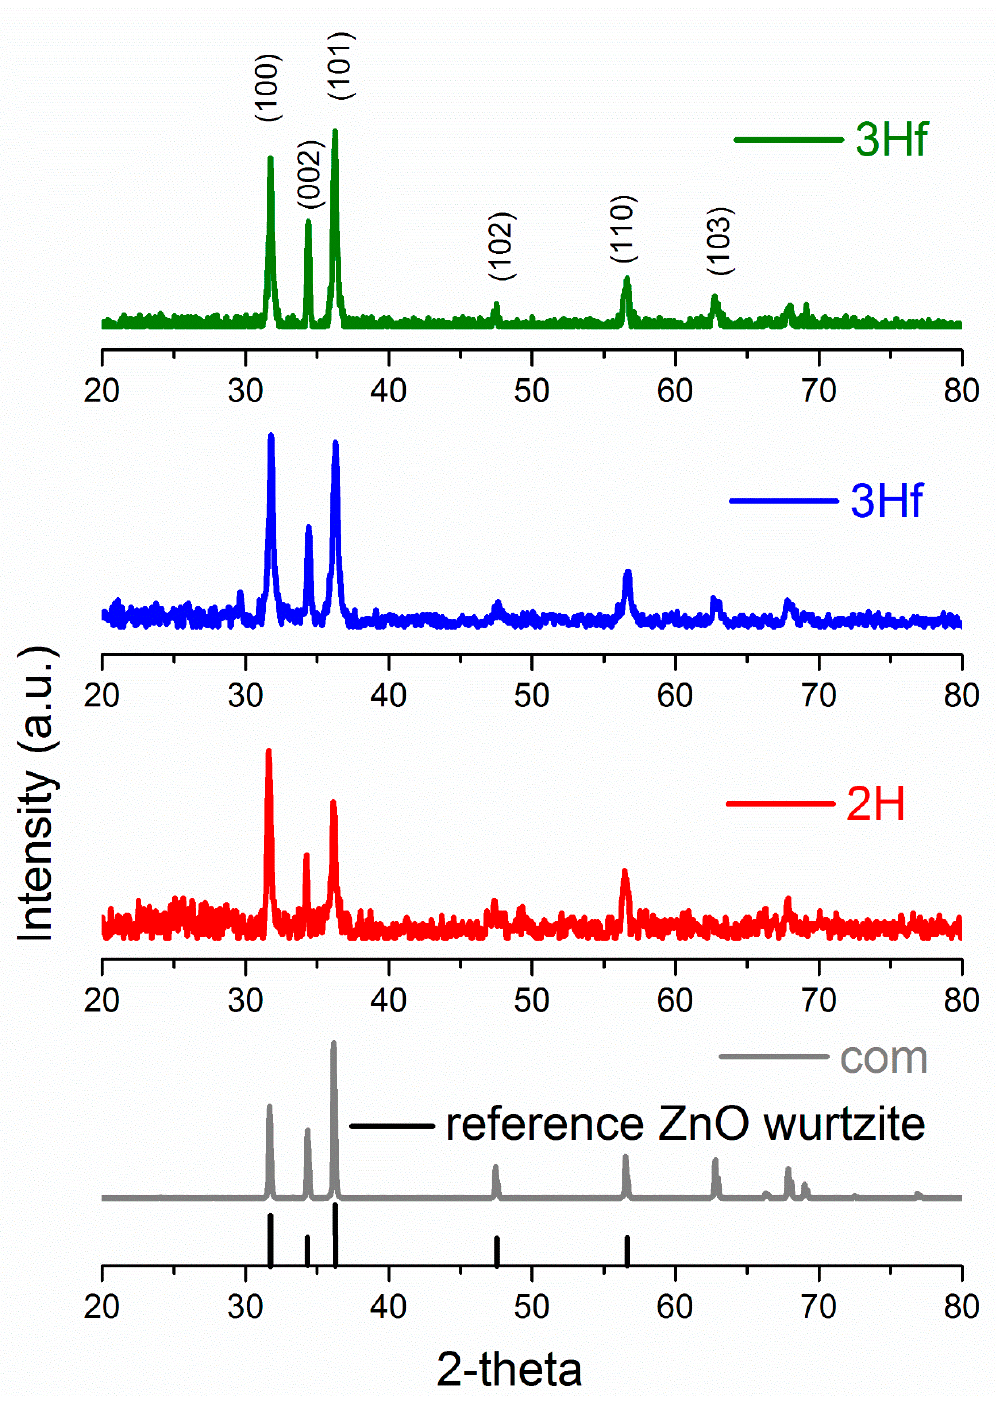
Figure 3. X-ray diffraction patterns of commercial ZnO (gray), and ZnO synthesized by bipolar electrochemical process after 2 h and collected by filtration (2H, red), 3 h and collected by filtration (3Hf, blue) and 3 h and collected by evaporation (3He, green). The reference signals of ZnO according to JCPDS card number 36-1451 are marked at the bottom in black.